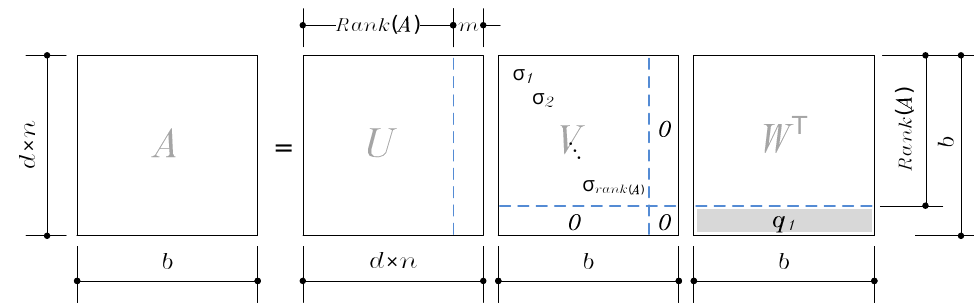
Figure 3. Graphical illustration of the SVD of the equilibrium matrix A